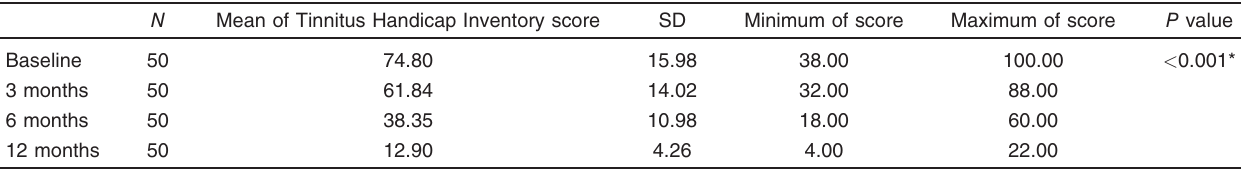
Table 7 Progress of Tinnitus Handicap Inventory score over 12